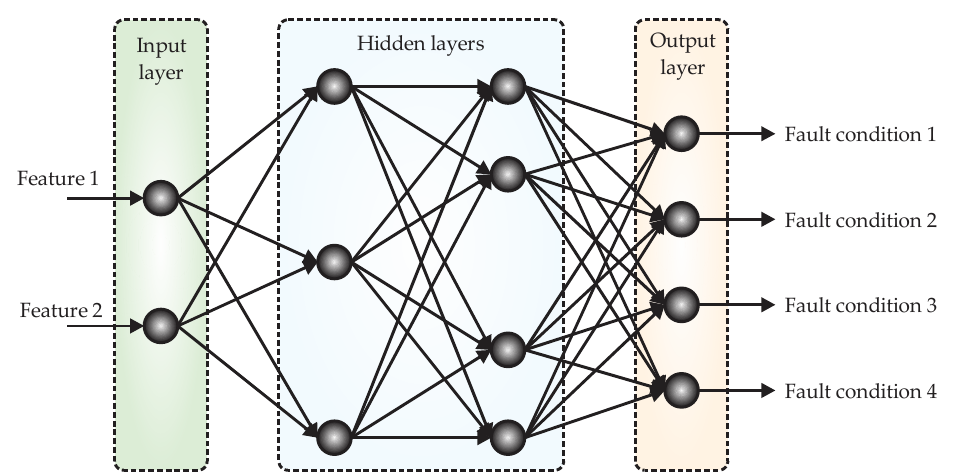
Figure 3. Structure adopted for the ANN.